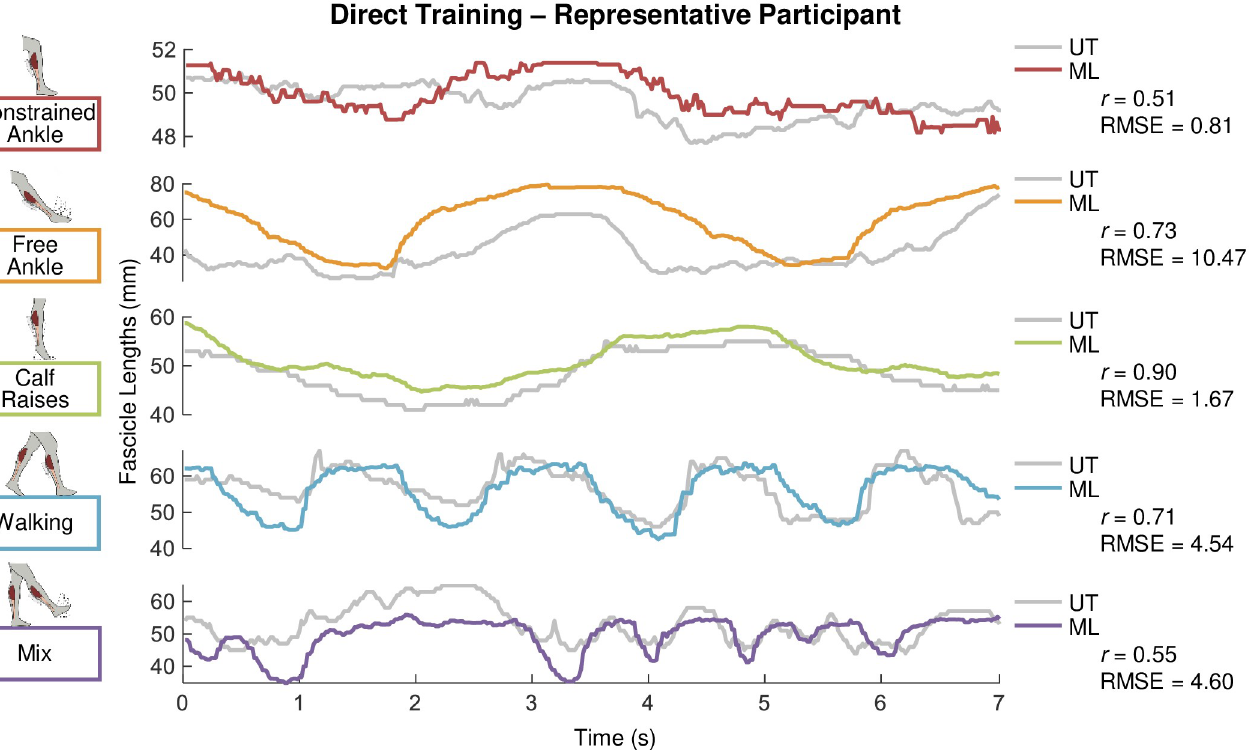
Fig 3. Muscle fascicle length versus time from optimized ML algorithm with direct training across tasks. Subplots show raw output of muscle fascicle length (mm) versus time (seconds) estimated using B-mode ultrasound images fed through a support vector machine (SVM) machine-learning (ML) model with optimized hyperparameters for a representative participant X during several cycles of a given ankle movement task (e.g., constrained ankle = red (top); mix = purple (bottom)). In each case, the SVM ML output was generated following a training procedure using image data from the same participant X and same task as that used to measure muscle fascicle length in the test participant X (i.e., direct task to task training). Muscle fascicle lengths derived from inputting the same B-mode images into UltraTrack (UT) software (gray) are included as ‘ground-truth’ to give context regarding correlation and RMSE across tasks. Note that scaling of Y-axes differs from panel to panel.